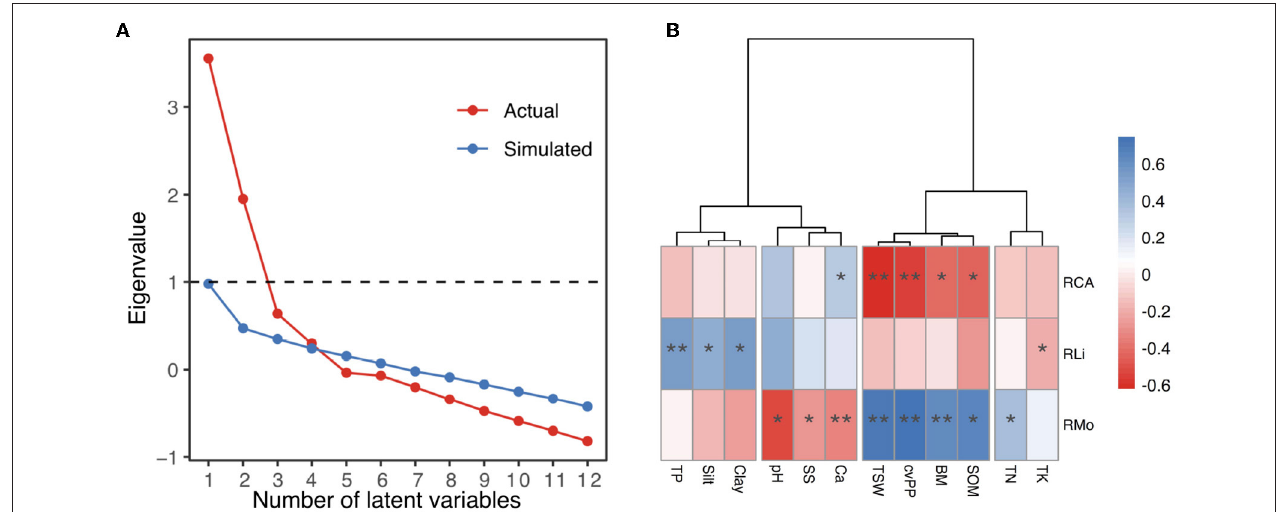
FIGURE 4 | (A) Scree plot of the successive eigenvalues to determine the number of representative latent variables of environmental variables. The horizontal dashed line marks two eigenvalues greater than 1 (Kaiser criterion). The break point occurs between 3-5 at the rank of actual eigenvalues (Cattell’s scree test). Four eigenvalues from the actual data correlation matrix are higher than eigenvalues from the random correlation matrices (parallel analysis). (B) Correlations between the environmental variables and richness of mosses, lichens, and cyanobacteria-algae. The cluster tree divides the environmental variables into four groups according to the scree plot. Significant code: ** P < 0.01 and * P <